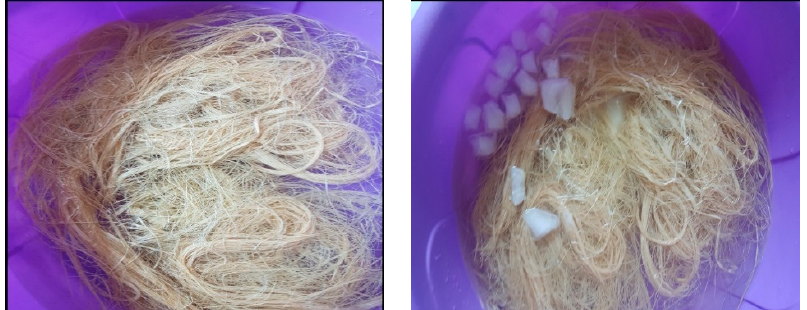
Figure 3. Submerging banana fibers in NaOH solution.